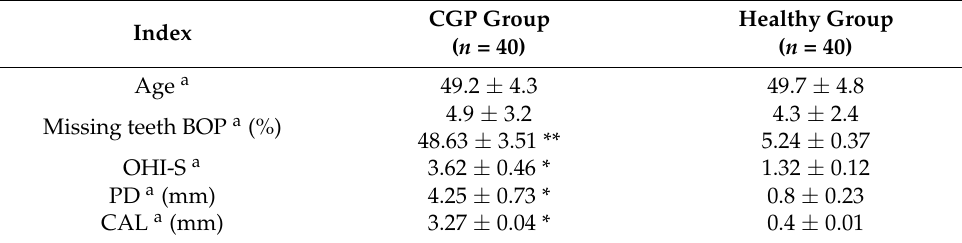
Table 1. Baseline Clinical Features of the